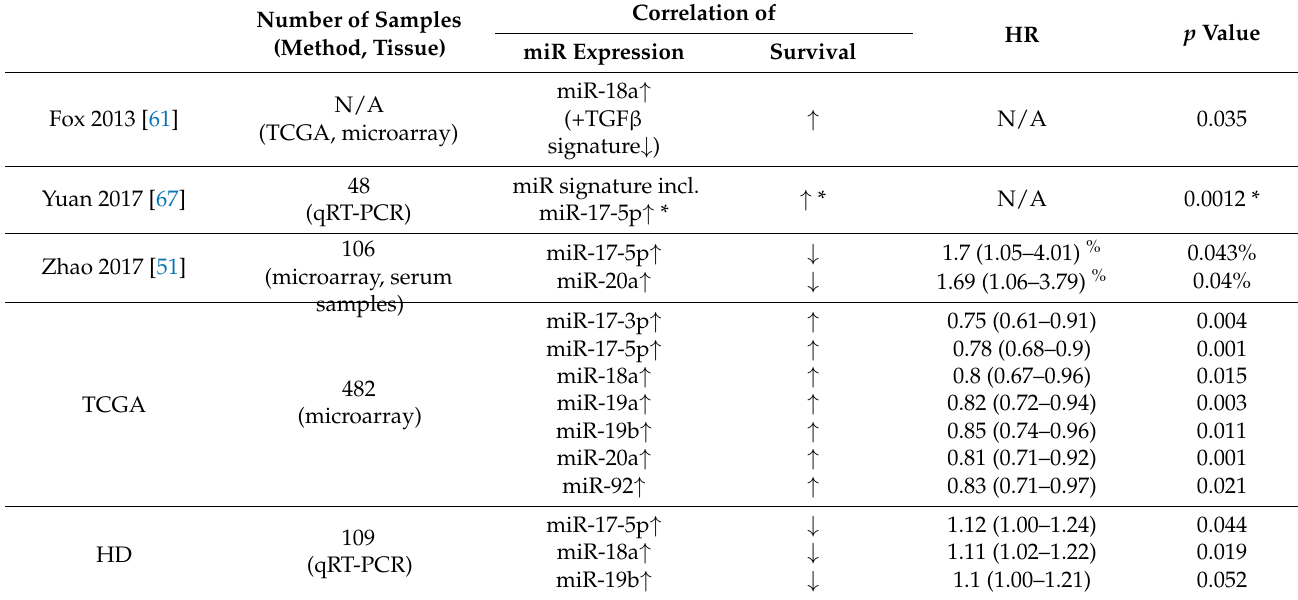
Table 4. Summary of previously published data on the correlation between miR-17-92 expression and the survival of GBM